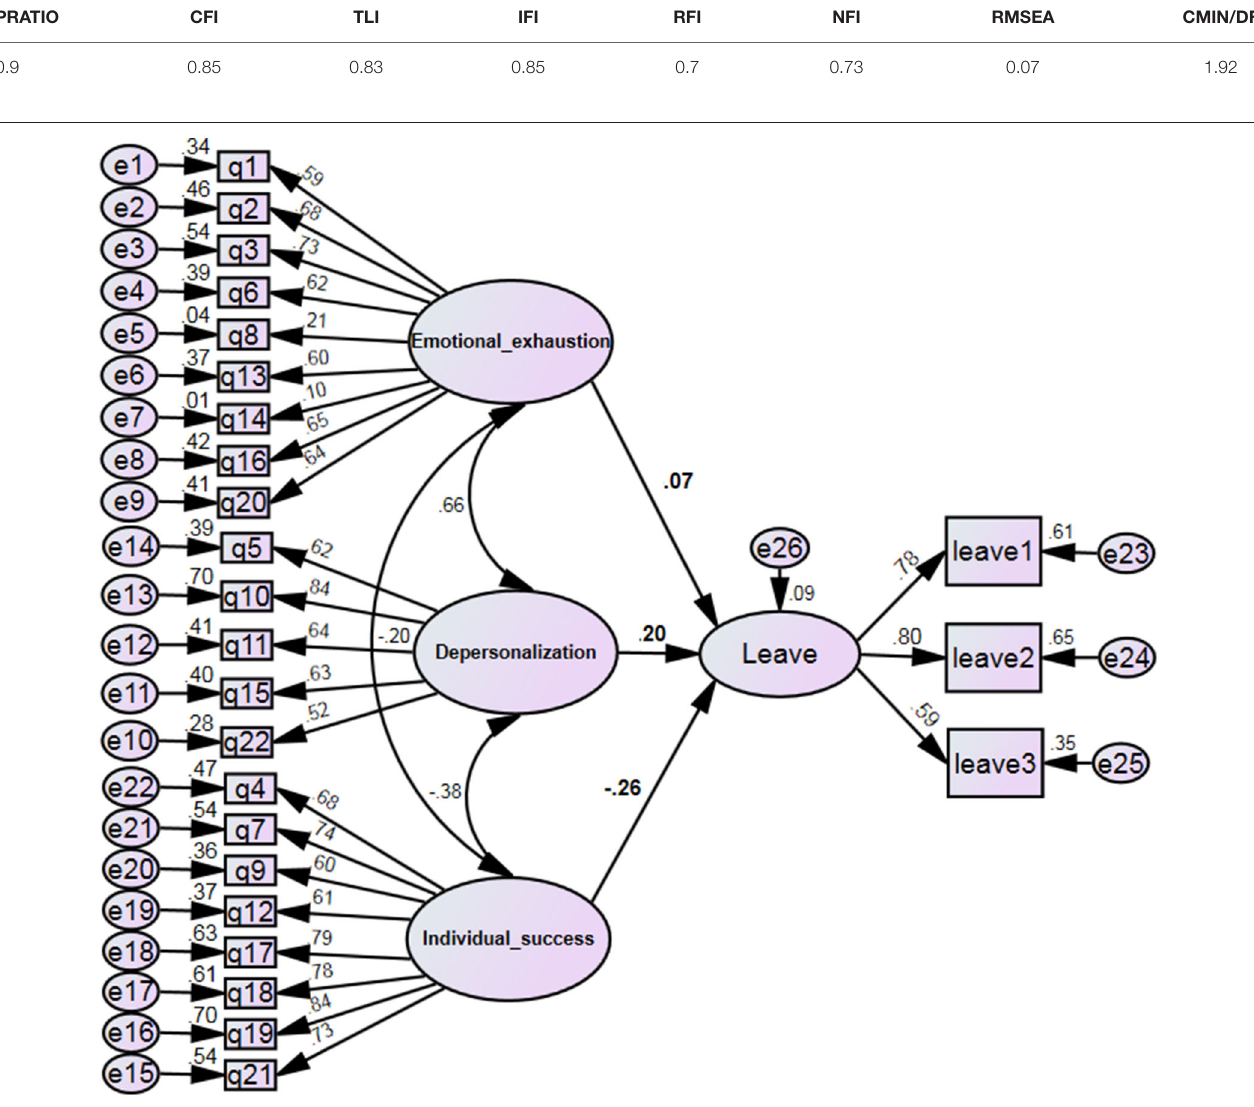
FIGURE 1 | Structural model of research with standard